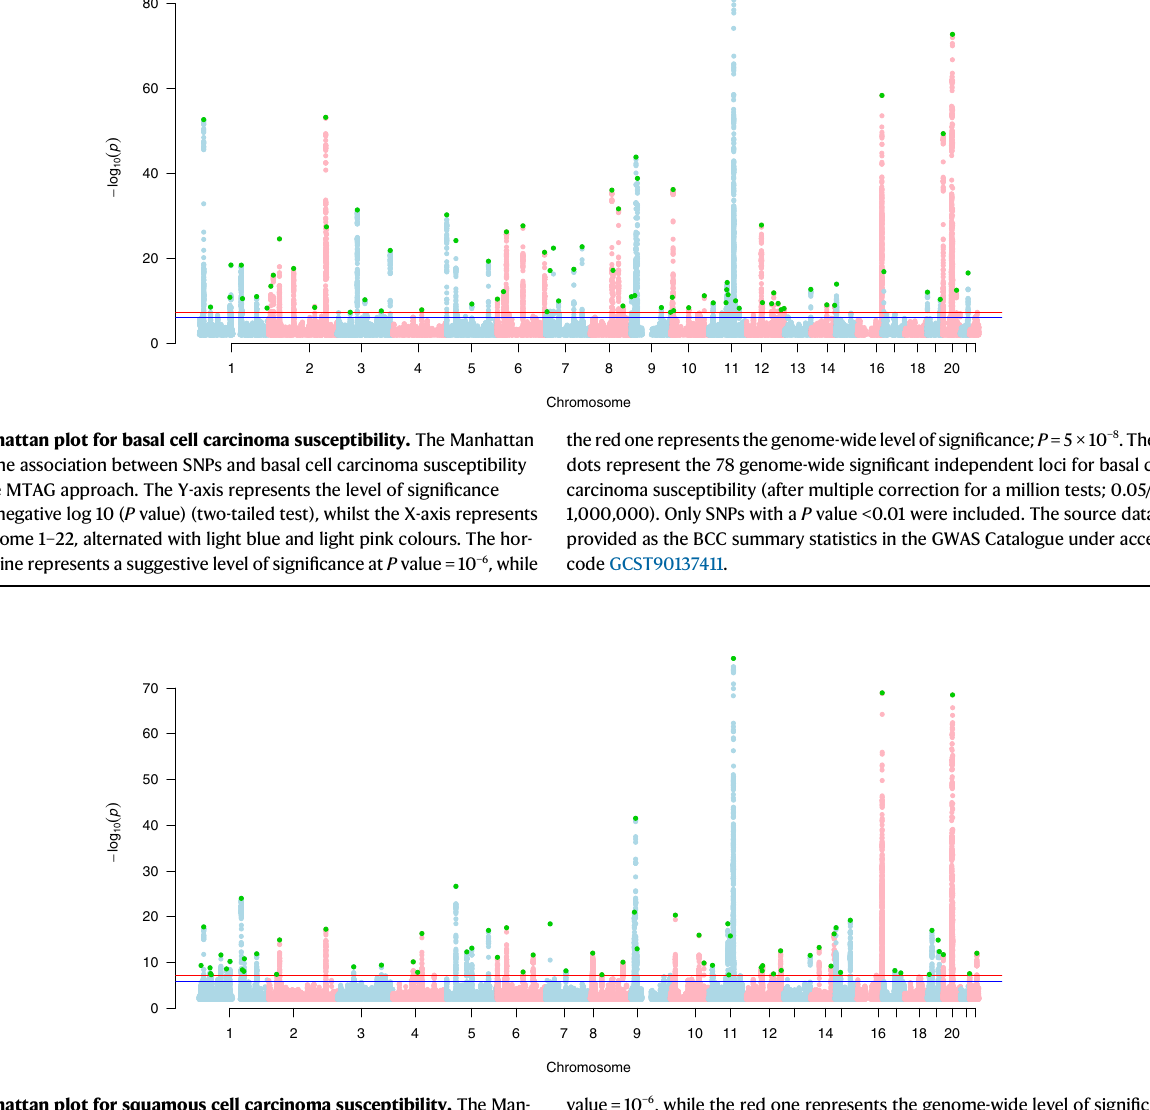
value=10 − 6 , while the red one represents the genome-wide level of signi fi cance; P =5×10 − 8 . The green dots represent the 69 genome-widesigni fi cant independent loci for squamous cell carcinoma susceptibility (after multiple correction for a million tests; 0.05/1,000,000). Only SNPs with a P value <0.01 were included. The source data fi le is provided as the BCC summary statistics in the GWAS Catalogue under accession code